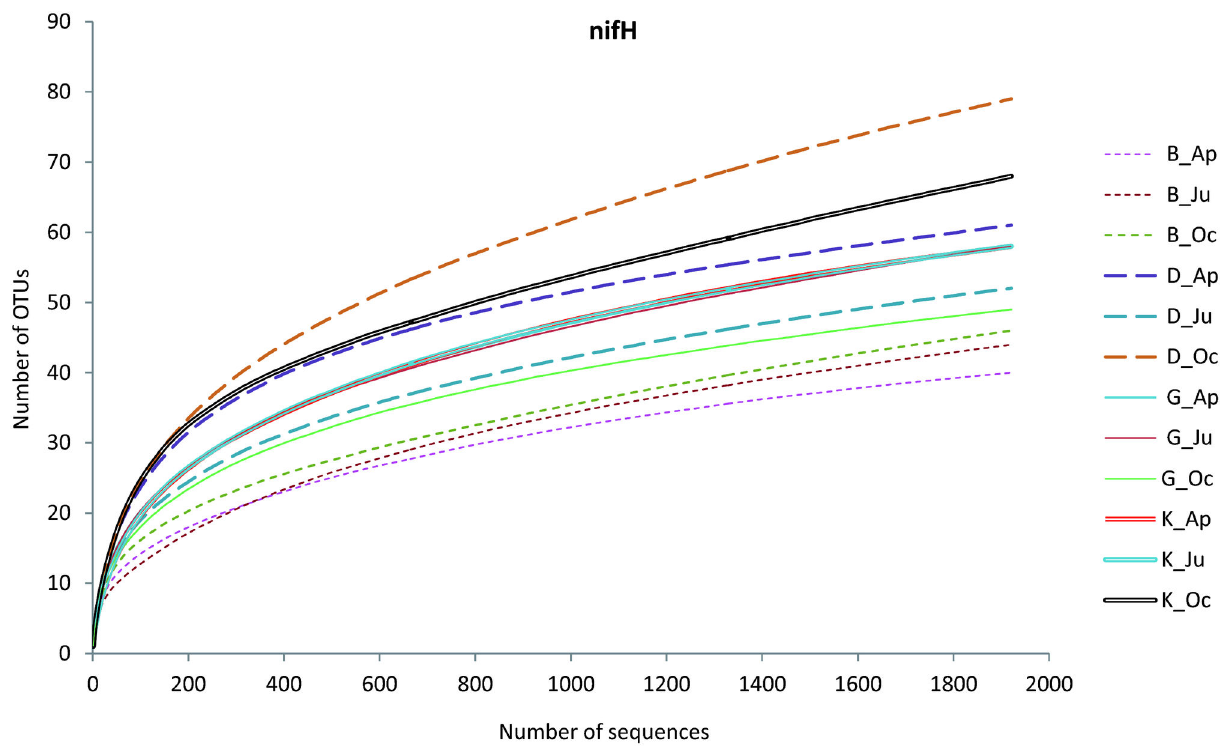
Figure 3. Rarefaction analysis of the diversities of nif H gene. Analyses of four soils across three sampling times after resampling of the sequences to the same depth (1921 sequences). The OTUs were classified at 90% similarity cutoff based on amino acid sequences. B, Buinen; D, Droevendaal; K, Kollumerwaard and G, Grebbedijk; Ap, April; Ju, June; Oc,